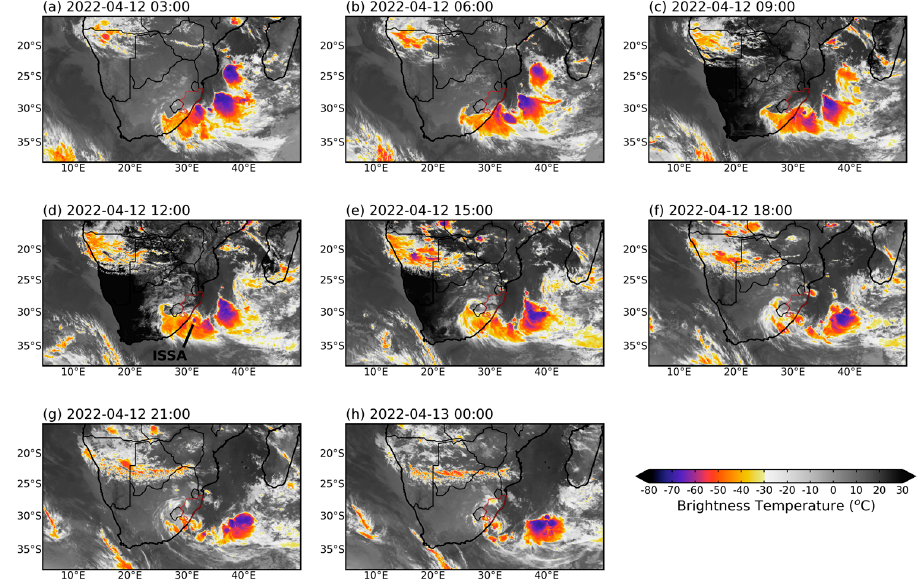
Figure A3. Brightness temperature (shaded; °C) taken from EUMETSAT Meteosat infrared satellite data at 3 h intervals (from left-hand side to right-hand side) starting at ( a ) 0300 UTC 12 April 2022 (top left-hand side) through to ( h ) 0000 UTC 13 February (bottom centre) at 3 hourly intervals. The location of the Subtropical Depression “Issa”, discussed in the text, is highlighted in panel ( d ).